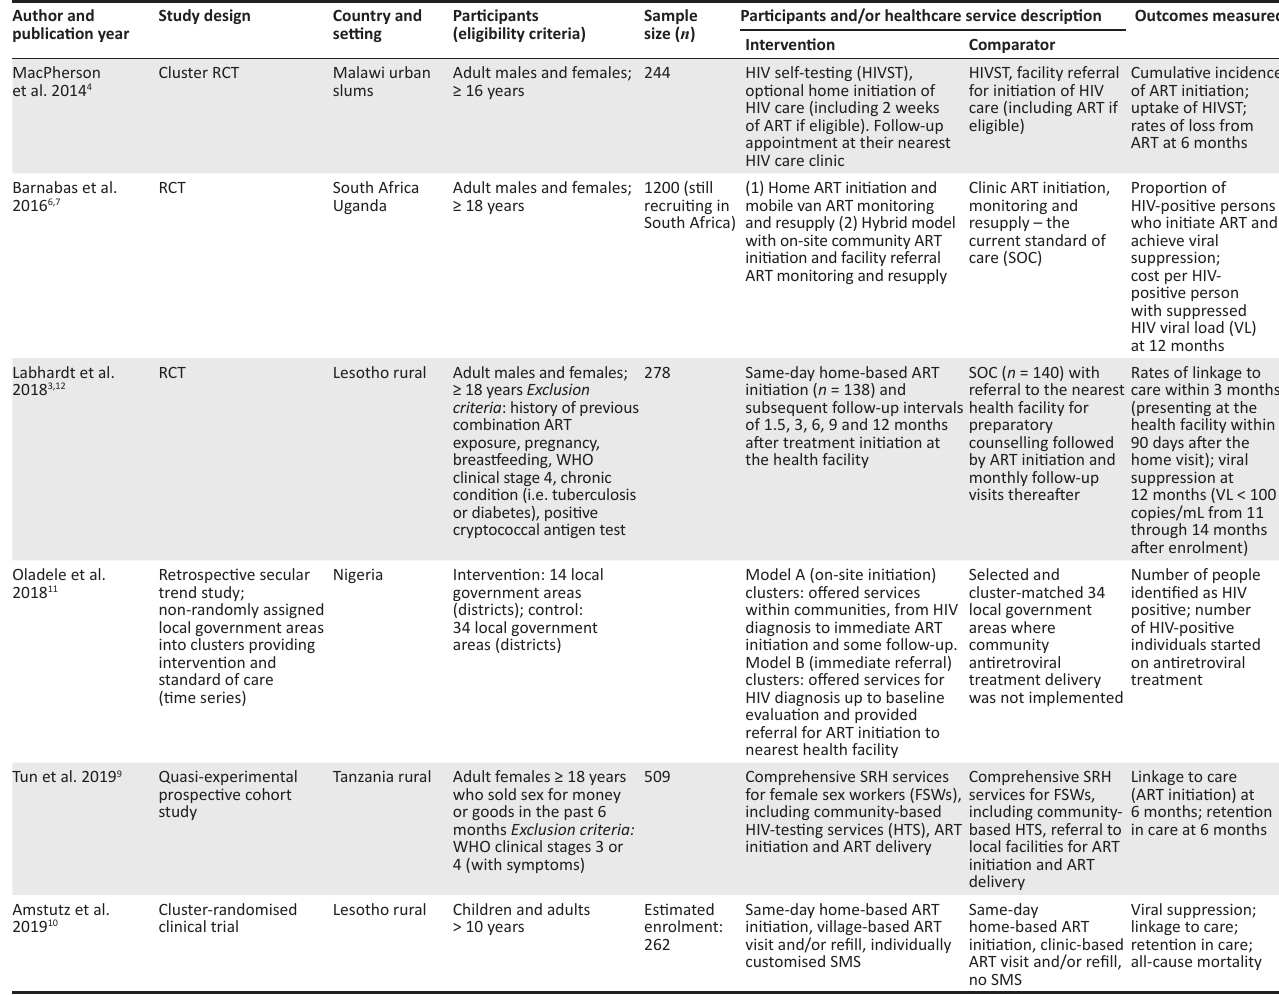
TABLE 1: Description of studies included in the